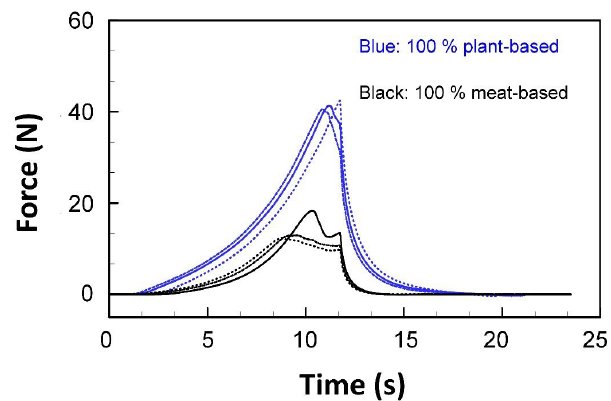
Figure 3. Compression response of commercially available hotdogs made with plant-based ingredients (blue) versus meat (black) at a compression speed of 1 mm s −1 .